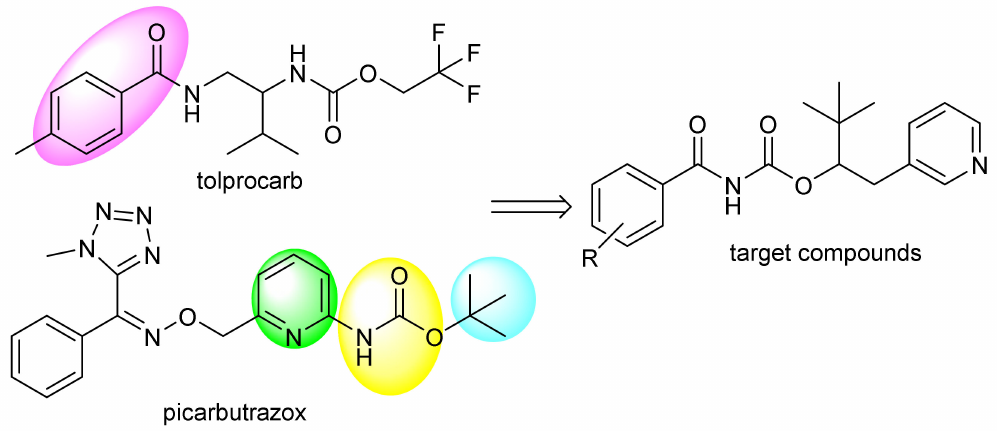
Figure 1. Rational design of novel